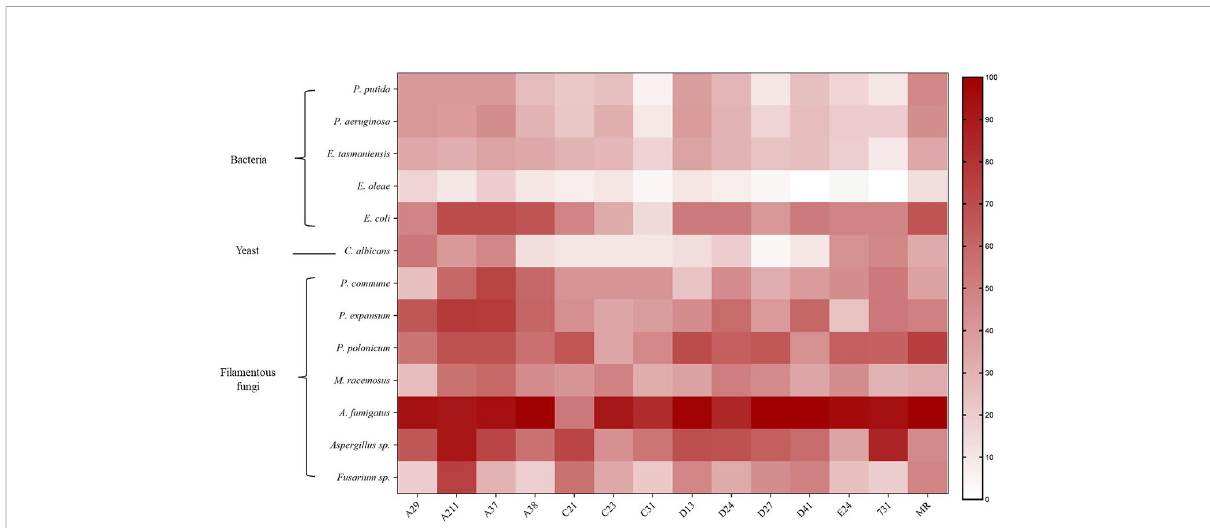
FIGURE 4 Inhibition rate of VOCs produced by yeasts on different microbes. X-axis indicates yeast strains; Y-axis indicates tested microbes; n=3; different color means different inhibition rate: the darker the color block was, the higher the inhibition rate was.